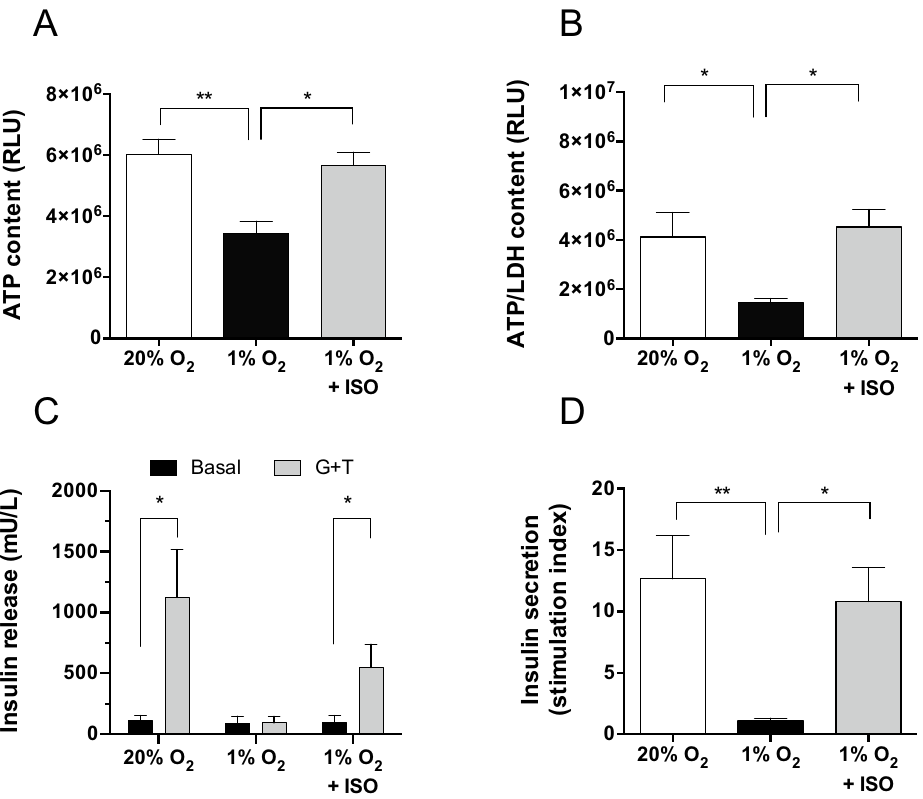
Figure 3. Viability and function of MIN6 pseudo-islets (MPIs) embarked in O 2 -balanced BAP. Alginate encapsulated MPIs (3000 IEQ/150 µL) were cultured for 3 days under 20% O 2 (positive control, white) or 1% O 2 condition without O 2 strategy (negative control, black) or with innovative strategy of oxygenation (ISO) composed of silicone-CaO 2 disk and 500 µg/mL HEMOXCell by alginate (1% O 2 + ISO, grey). ( A ) Total metabolic activity (ATP content, RLU), ( B ) viability (ATP/LDH ratio, RLU/AU), ( C ) Glucose plus theophylline (G + T) responsive insulin release by 30 min sequential incubations of alginate encapsulated MPIs in basal medium (black bar) and glucose plus theophylline stimulation (grey bar), ( D ) Stimulation index (ratio of high glucose plus theophylline stimulation over basal insulin secretion). Results from independent experiments (n = 5–9) are expressed as mean ± SEM. *p < 0.05, **p < 0.01 (unpaired parametric